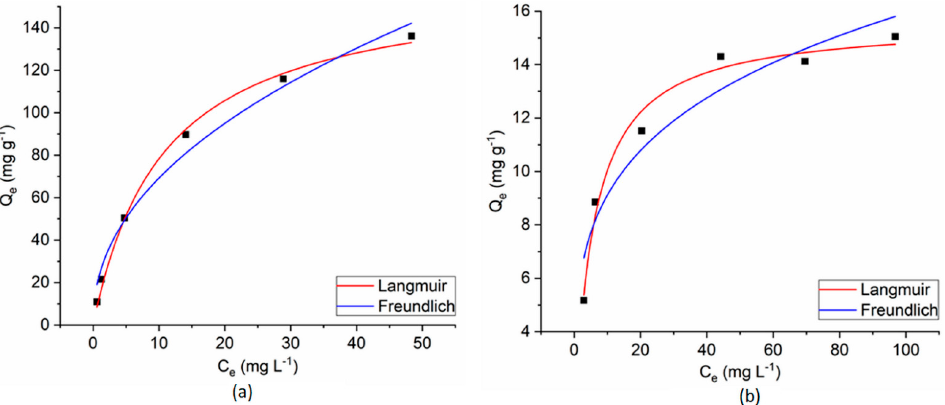
Figure 15. Langmuir and Freundlich fitting curves for CR adsorption onto CoFe 2 O 4 ( a ) and CoFe 2 O 4 − Chit ( b ) from a single component solution.